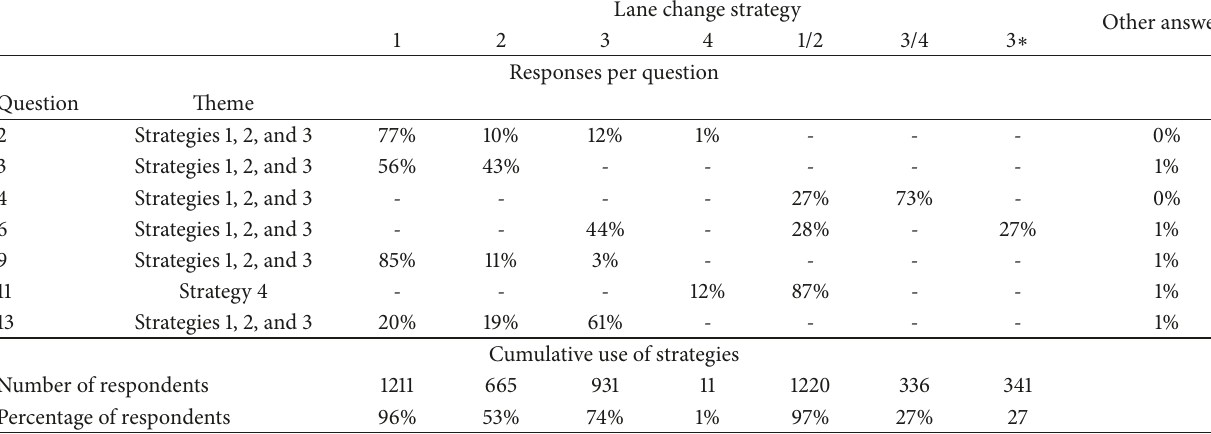
Table 3: Distribution of respondents over the lane change strategies.